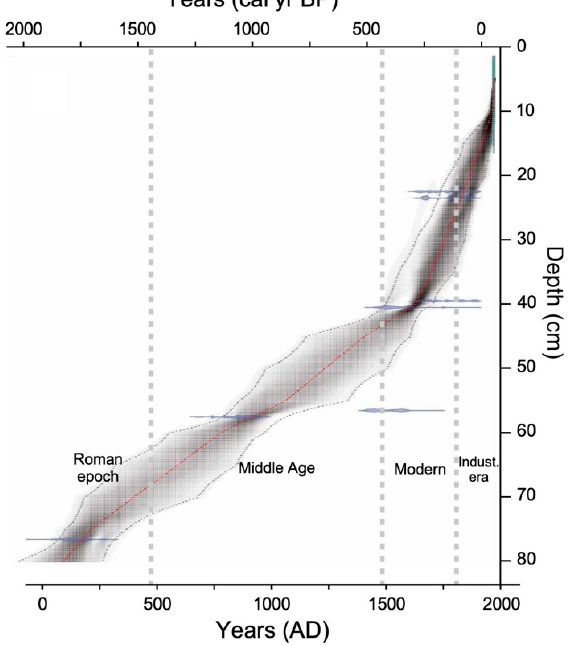
Figure 2. Depth distribution of radiocarbon measurements (violin plots), shown together with an age ∿ depth Bayesian model and the associated regional cultural chronology (bottom).